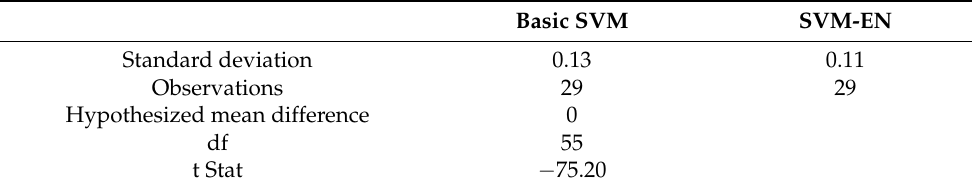
Table A4. t -test: two-sample assuming unequal variances between basic SVM and SVM-EN, simple